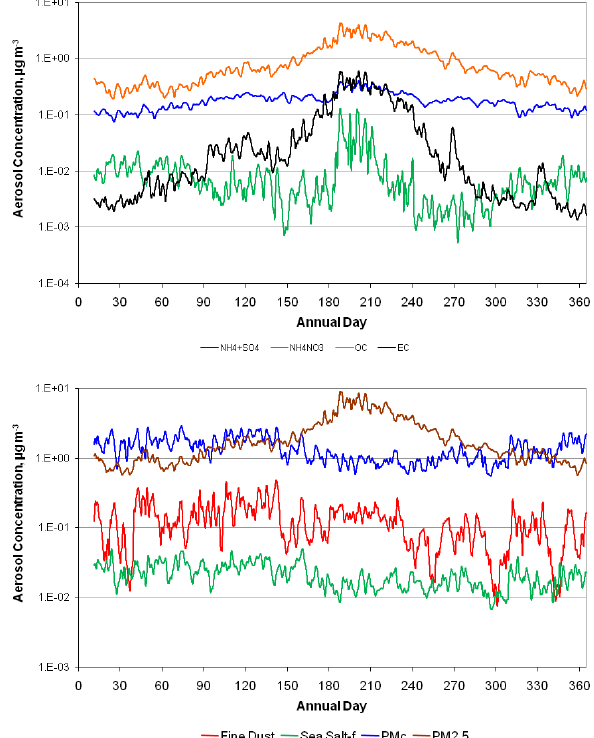
Fig. 5. Grid-averaged time series of simulated particle concentrations for the natural emissions simulation of 2002. Diurnal noise was removed by applying a 24-hr averaging filter.